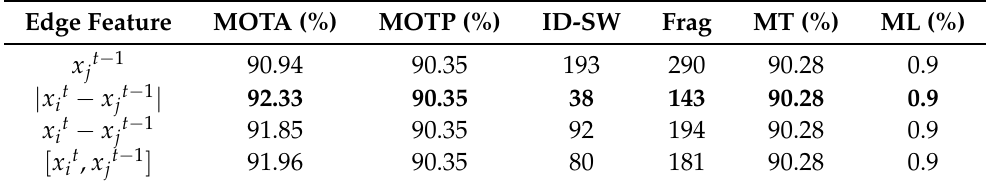
Table 3. Effectiveness of different edge feature aggregation operations.